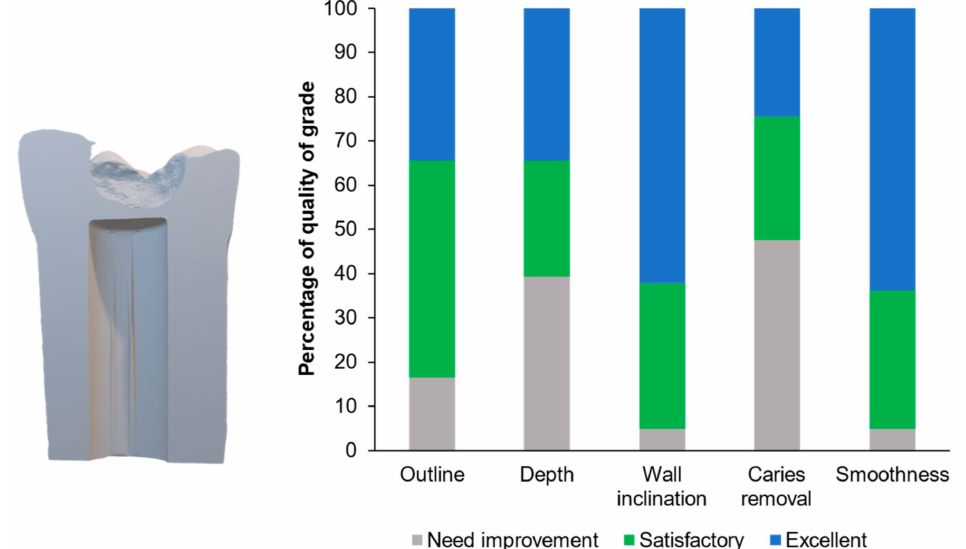
Figure 7. Percentage of grades for each parameter evaluated for the occlusal cavity